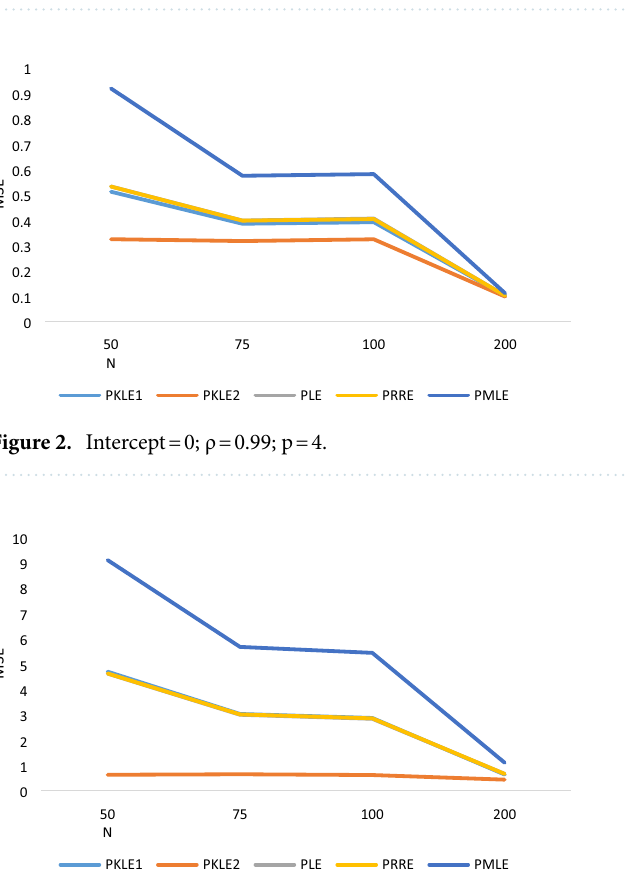
Figure 1. Intercept = − 1; ρ = 0.95; p = 4.